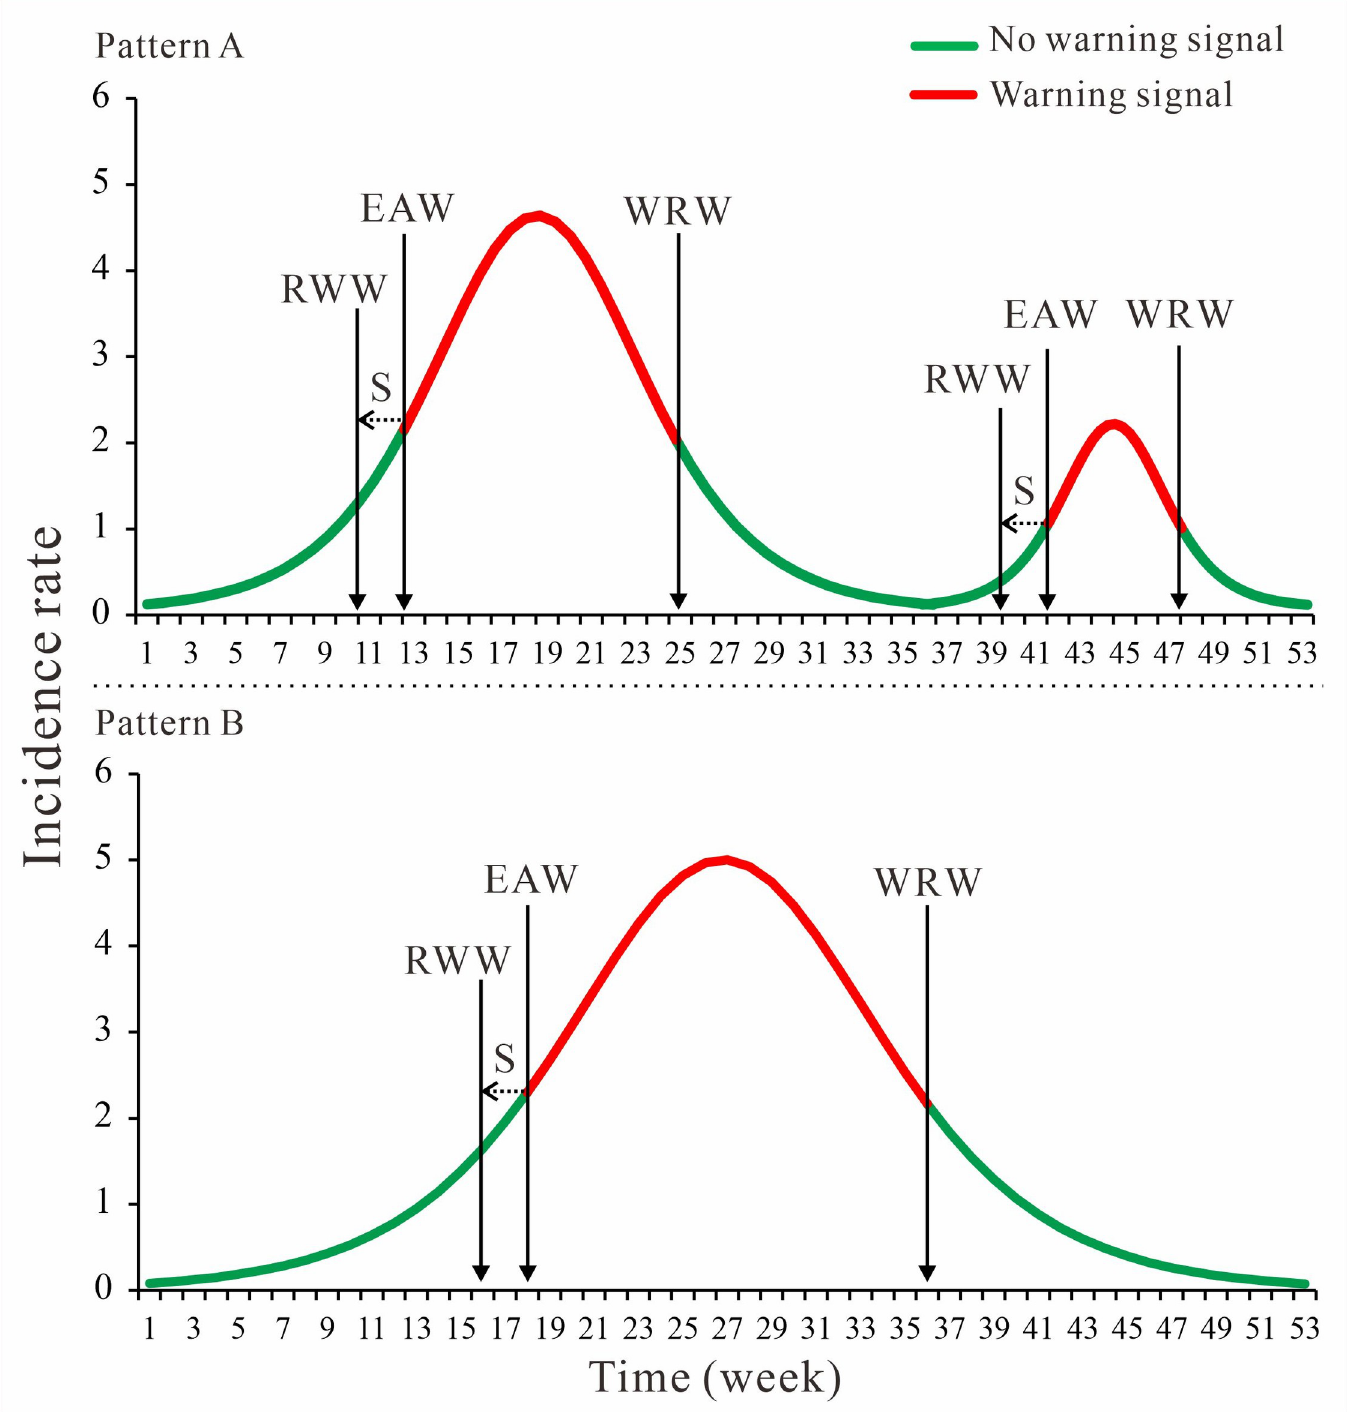
Fig 2. Diagram of method to determine early warning week of HFMD in epidemic cycle. ( S is the standard deviation; EAW is epidemic acceleration week; RWW is recommended warning week; WRW is warning removed week).